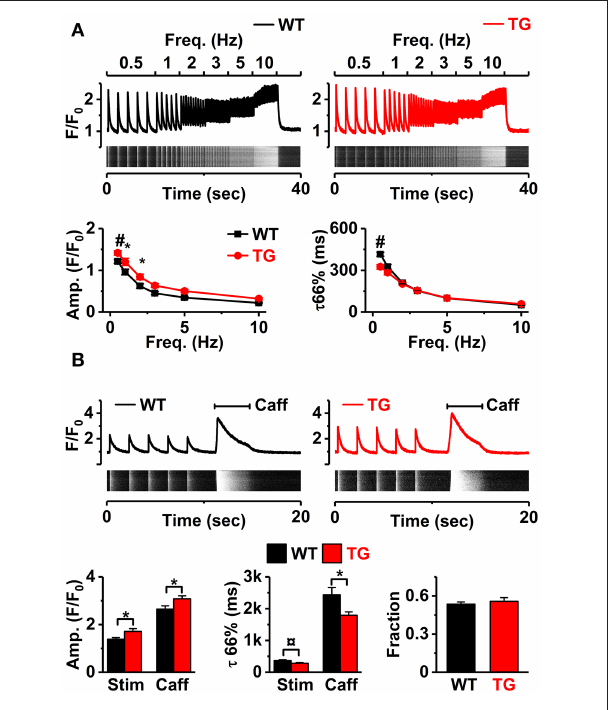
FIGURE 3 | Ca 2 + handling in VEGF-B TG ventricular myocytes. (A) Representative [Ca 2 + ] i transients (line-scans) and their profiles in Fluo4-loaded cardiomyocytes upon pacing at different stimulus frequencies in WT and TG mice (upper), frequency dependence of amplitudes (lower left), and time constants (lower right) of the [Ca 2 + ] i transients ( n = 16 myocytes for WT and n = 22 myocytes for TG, at least three animals were used for both groups). (B) Representative line-scans and profiles of stimulus- and caffeine-induced [Ca 2 + ] i pulses in WT (upper left) and TG mice (upper right). Amplitudes (lower left) and time constant of decays (lower middle) of stimulus- (Stim) and caffeine-induced (Caff) transients, and fractional release (lower right, WT n = 23 myocytes and TG n = 26 myocytes, at least three animals were used for both groups). * P < 0.05, ¤ P < 0.01 and # P <